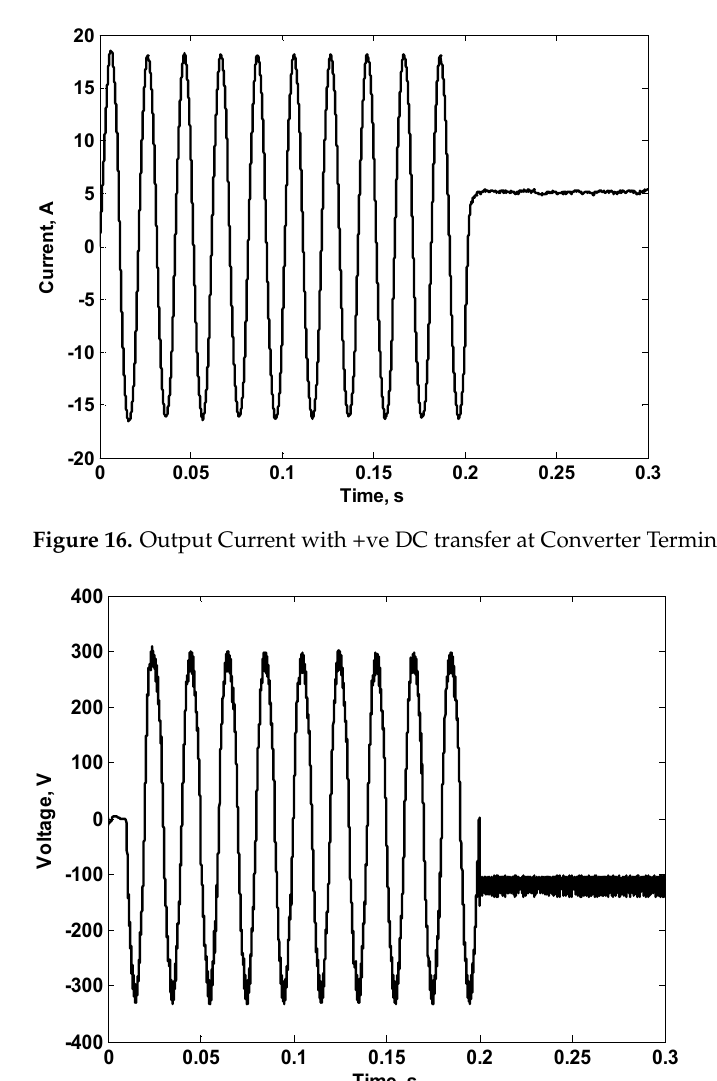
Figure 15. Output Voltage with +ve DC transfer at Converter Terminals.